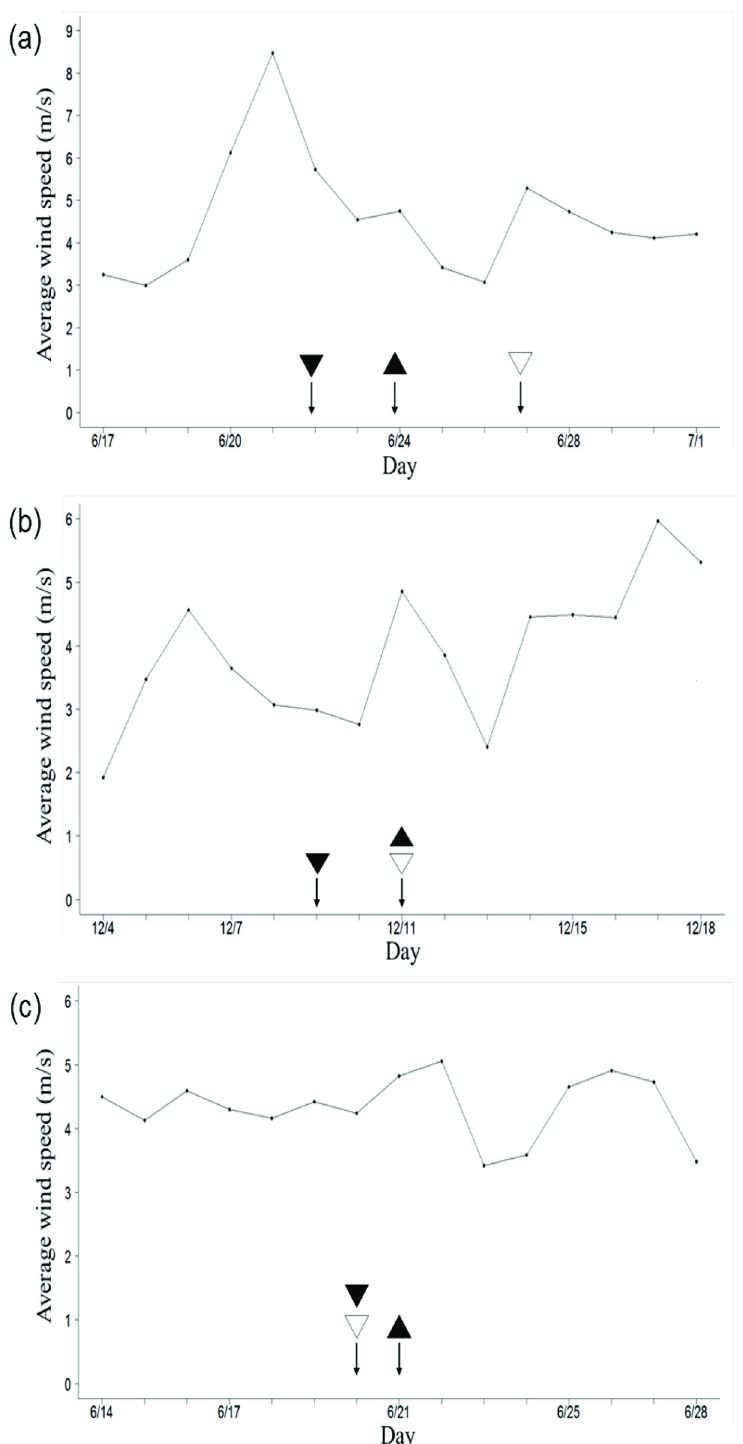
Fig 2. Average wind speed (m/s) for 7 days before and after 50% pollen silking. Crop seasons (a) 2009–1, (b) 2009– 2, and (c) 2010–1. ▲ : silking date of pollen recipient; ▼ : shedding date of pollen recipient, and 5 : shedding date of pollen